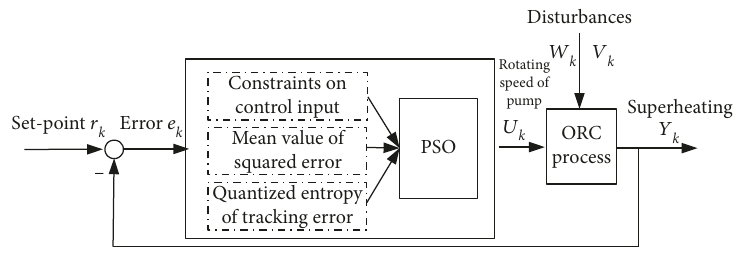
Figure 2: Schematic diagram of the proposed control